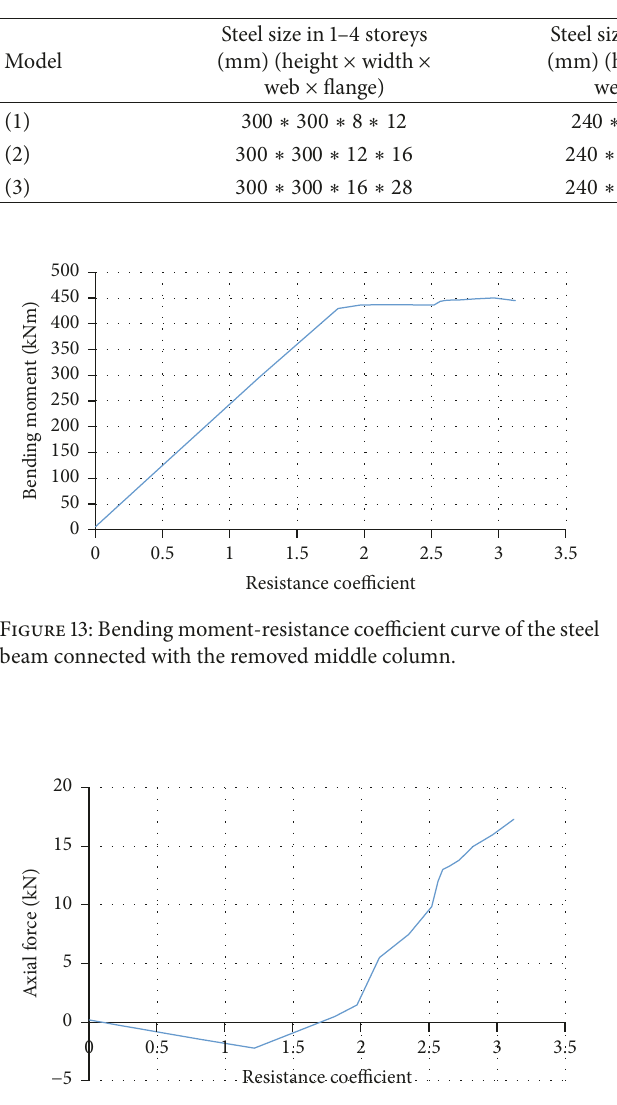
Figure 14: Axial force-resistance coefficient curve of the steel beam connected with the removed middle